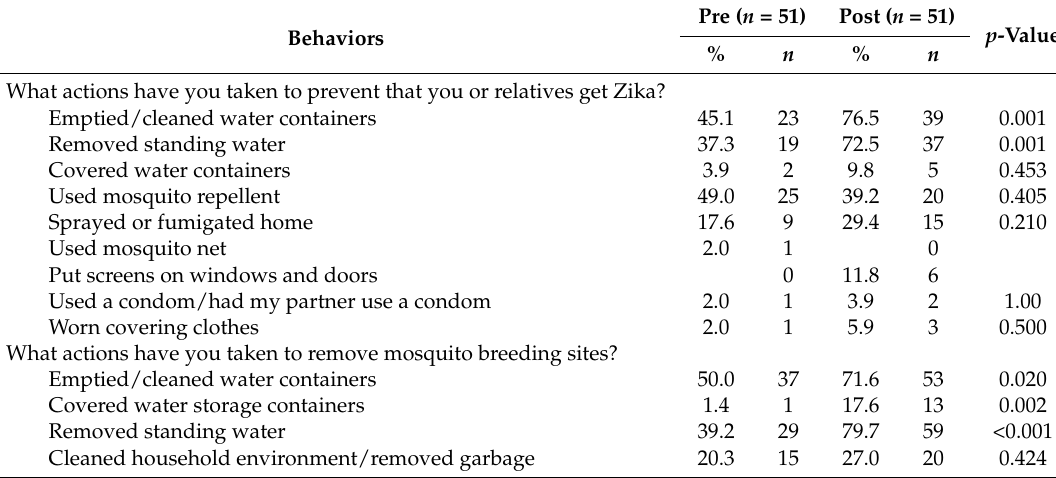
Table 3. Respondent’s preventive behaviors reported at pre and post-assessments.